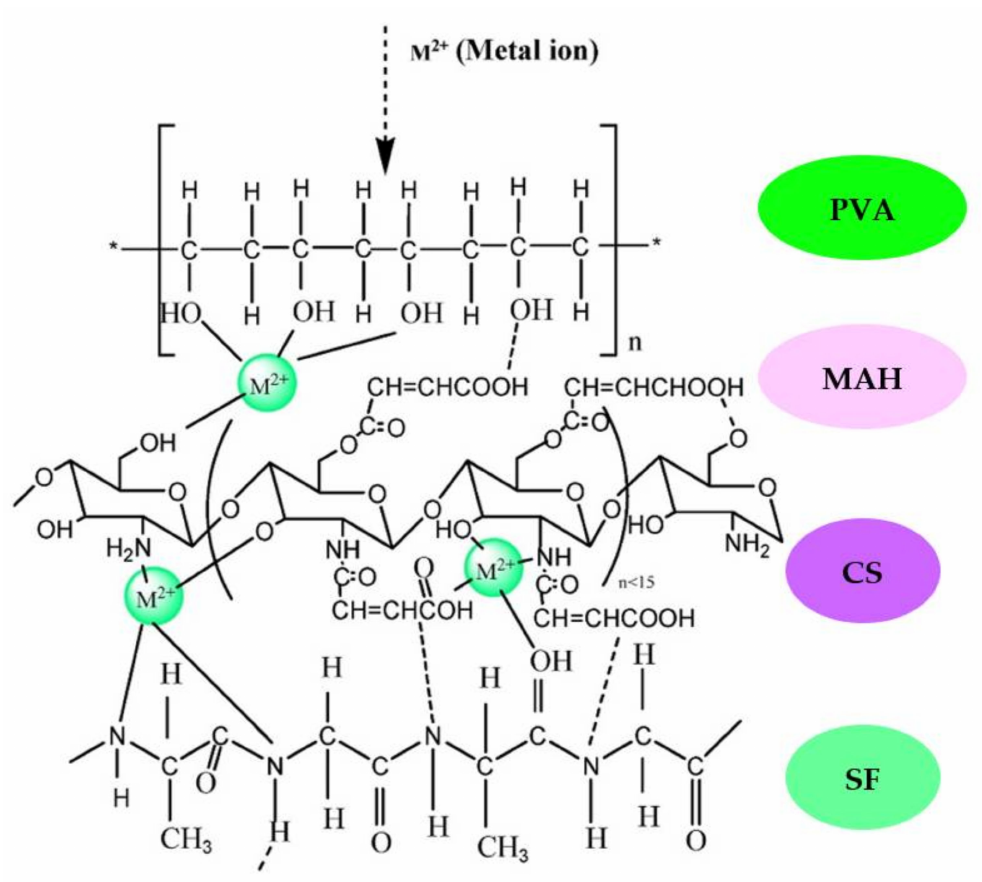
Figure 3. Structure of chitosan oligosaccharide-graft-maleic anhydride/poly(vinyl alcohol)/silk fibroin (CS/PVA/SF-gMAH)-binding heavy metals. Reprinted from